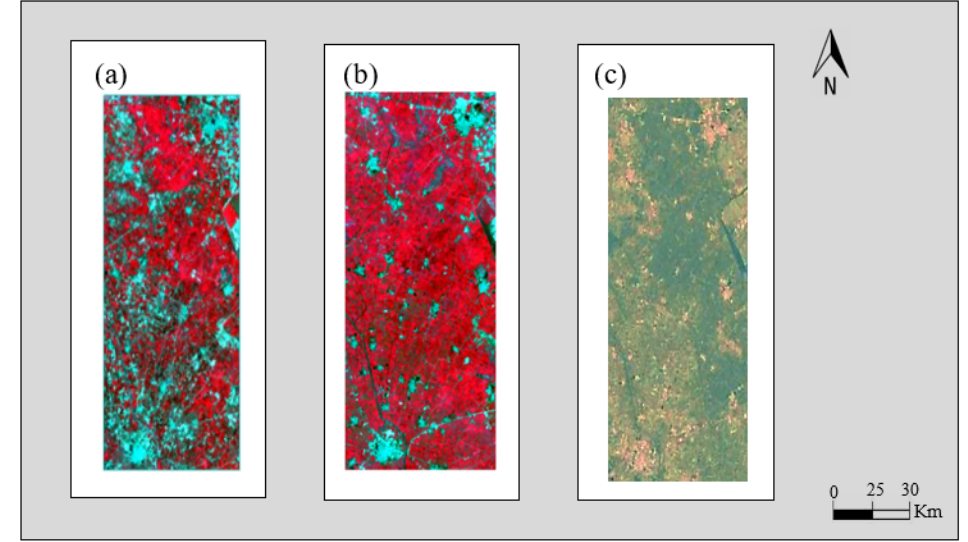
Figure 2. Representation of reflectance images acquired using Hyperion (RGB: 40:30:20): ( a ) 24 February 2005, ( b ) 9 February 2014, ( c ) Reference Image.